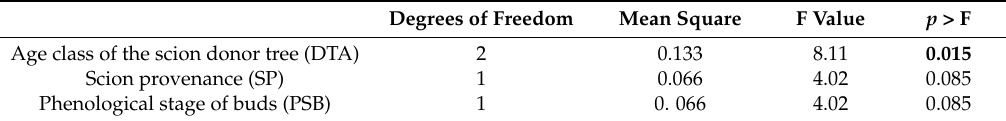
Table 6. Analysis of variance of survival of side veneer grafts of Pinus engelmannii Carr. Degrees of Freedom Mean Square F Value p >